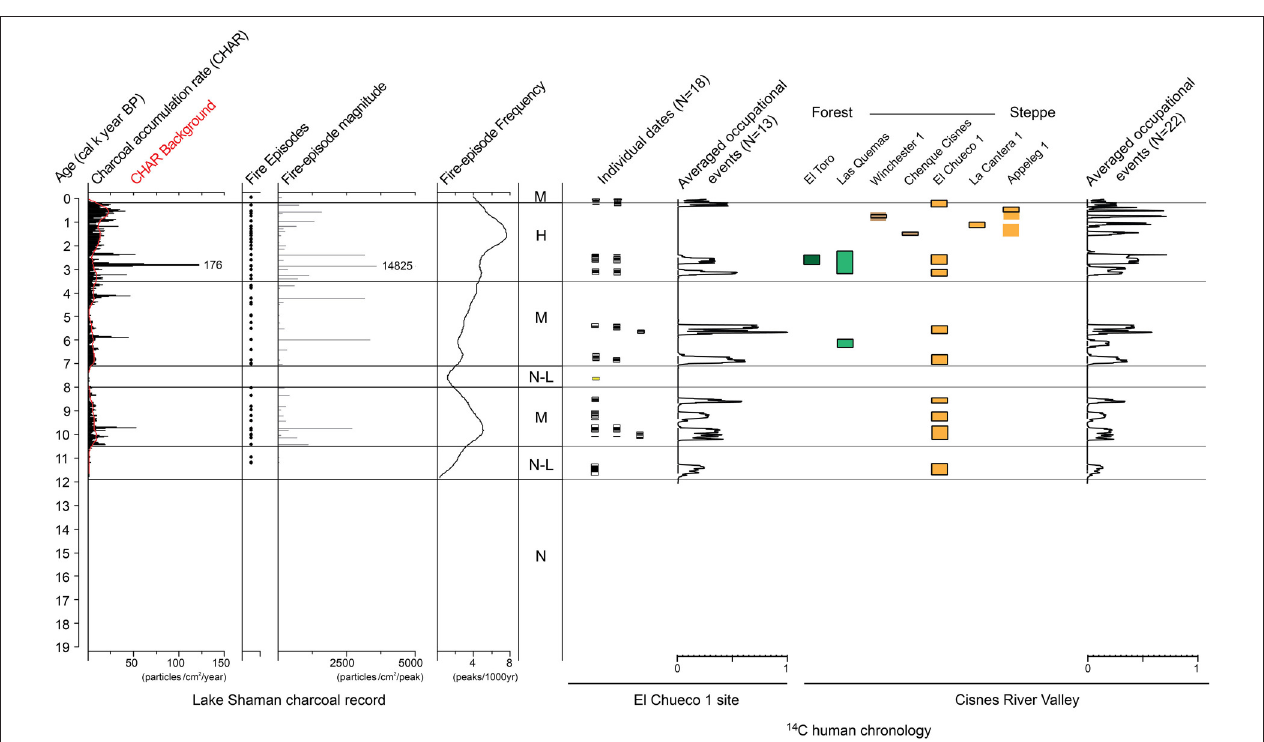
FIGURE 5 | Lake Shaman charcoal record (de Porras et al., 2012) plotted against 14 C dates from archeological sites in CRV. The charcoal record was divided into four categories: null (N), null-low (N-L), moderate (M), and high (H) fire activity. Individual dates are graphed in bar plots and the averaged